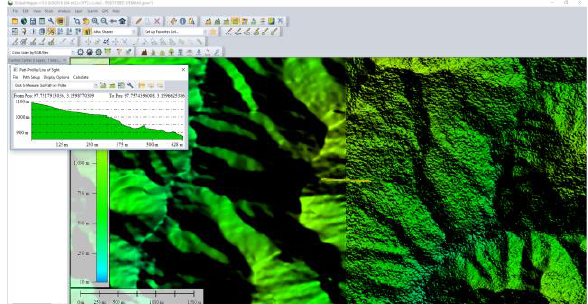
Figure 9. Visualization of TerraSAR-X (left) and IFSAR (right) DSM.